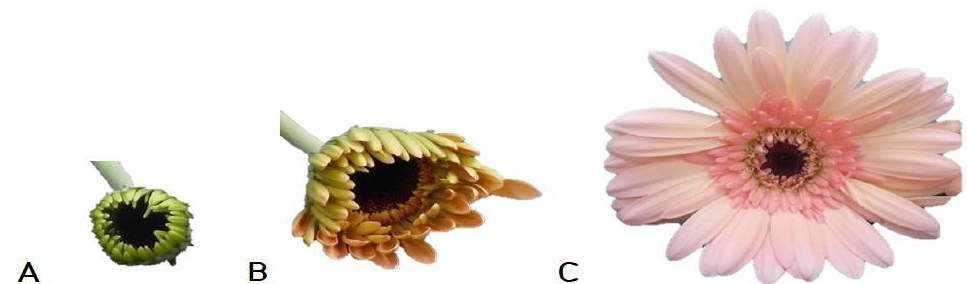
Figure 1. Flower developmental stages of gerbera ‘Harmony’. ( A ) Under 0.5 cm in ray flower length; ( B ) under 2.5 cm in ray flower length and starting to show pink color; ( C ) flower fully opened but stamens have not matured yet.